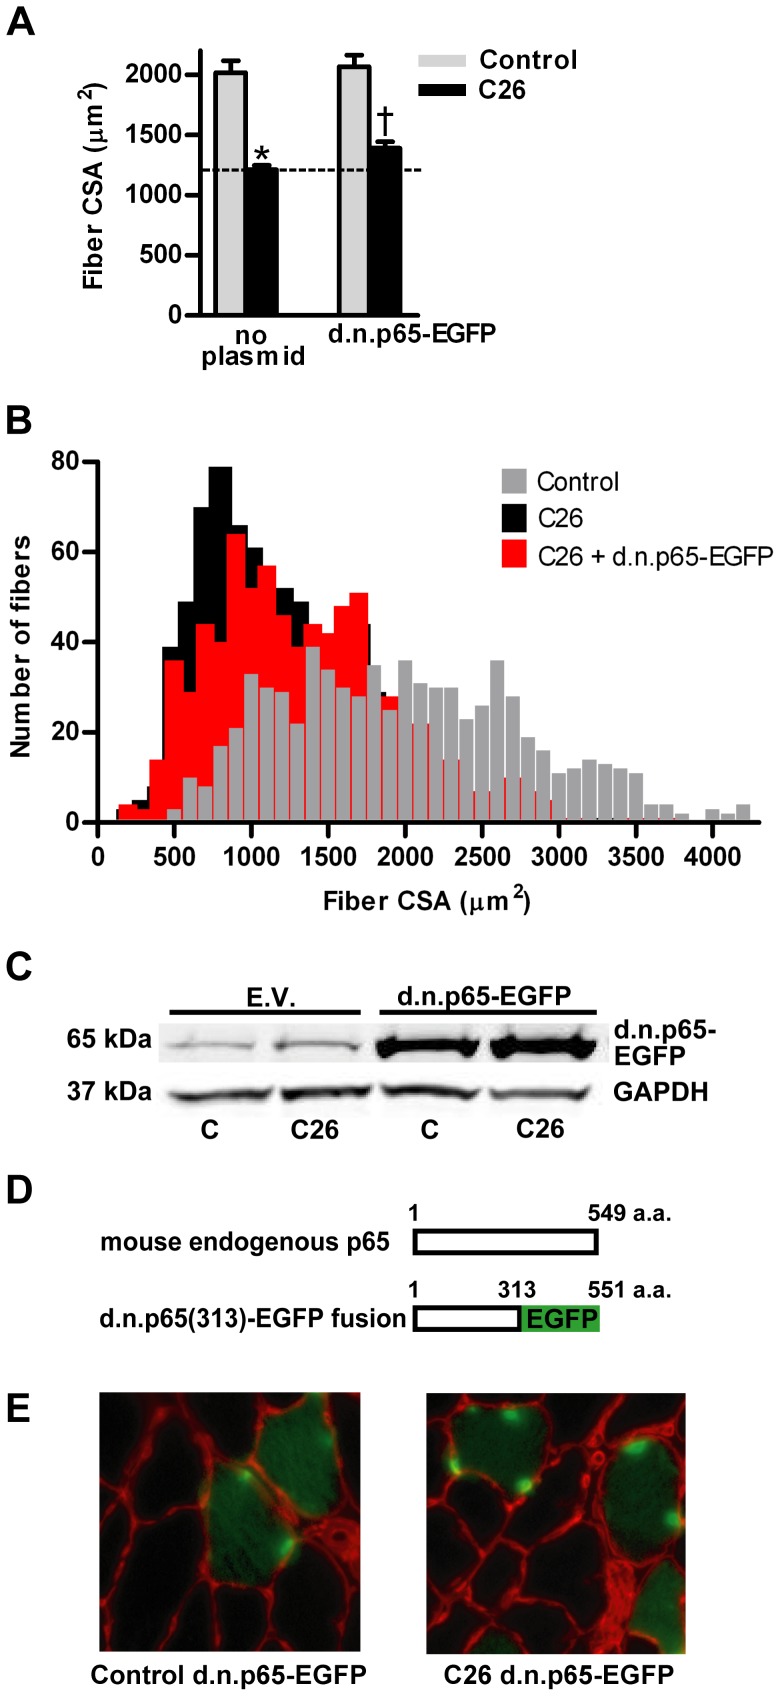
Effects of d.n.p65-EGFP on muscle fiber cross sectional area (CSA).(A) Mean tibialis anterior (TA) fiber cross-sectional area in control and C26 tumor-bearing mice in the presence or absence of d.n. p65-EGFP. Each bar represents mean fiber area from 8 muscles (± SE). (B) Fiber area frequency distribution of all fibers from muscles of control, C26, and C26 + d.n. p65-EGFP groups. (C) Western blots of lysates from TA muscles injected with the empty vector (EV) or d.n. p65-EGFP plasmid confirms overexpression of the fusion protein. (D) The d.n. p65(313)-EGFP fusion protein (313 a.a.+238 a.a. = 551 a.a. = 63 kDa) is of similar molecular weight as endogenous mouse whole p65 protein (549 a.a. = 60.2 kDa) and they are not separable on a 4-15% gradient polyacrylamide gel. All samples are from the same immunoblot. (E) Representative cross sections of TA muscles from control and C26 tumor-bearing mice injected with the d.n. p65-EGFP plasmid. C  =  control. * significantly different from control (P<0.05). † significantly different from C26 fibers not transfected with d.n.p65-EGFP (P<0.05).